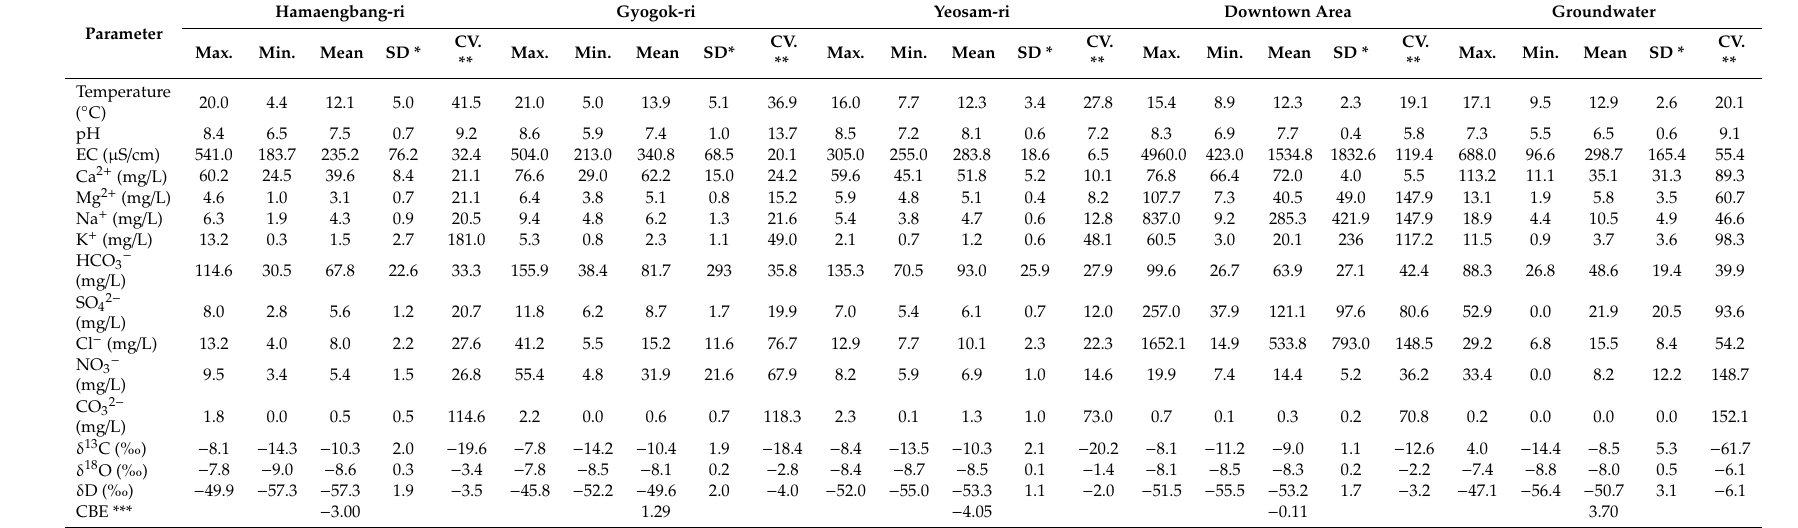
Table 1. Statistics of field parameters and ionic compositions of karst water for July 2019–April